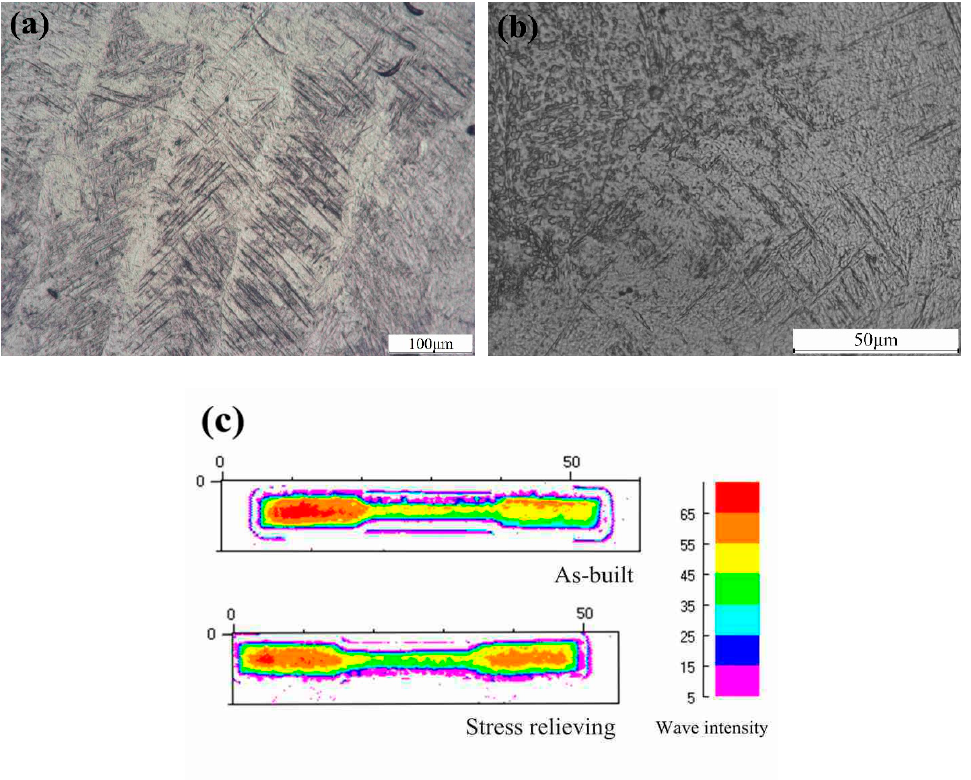
Figure 5. Optical microscopy in top surface: ( a ) the as-built sample; ( b ) middle portion of the stress relieving sample and ( c ) the echo amplitude diagram.